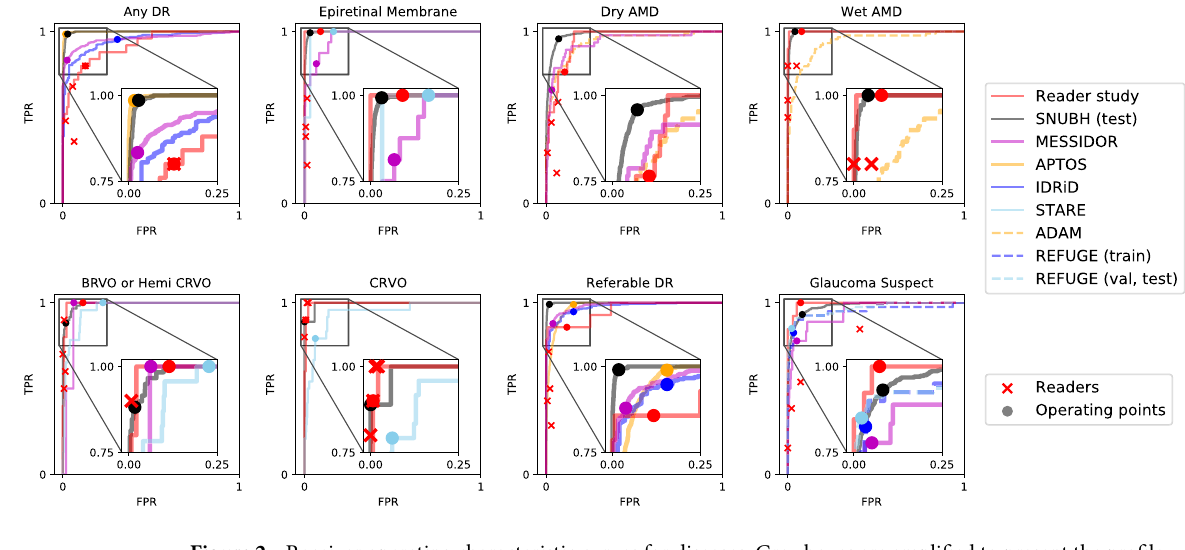
Figure 2. Receiver operating characteristic curves for diseases. Gray boxes are amplified to present the profile of the curves in a practical range. Operating points of the models are marked with circles and performance of human readers are plotted with cross marks. Receiver operating characteristic curves for ADAM dataset is identical for dry AMD and wet AMD.